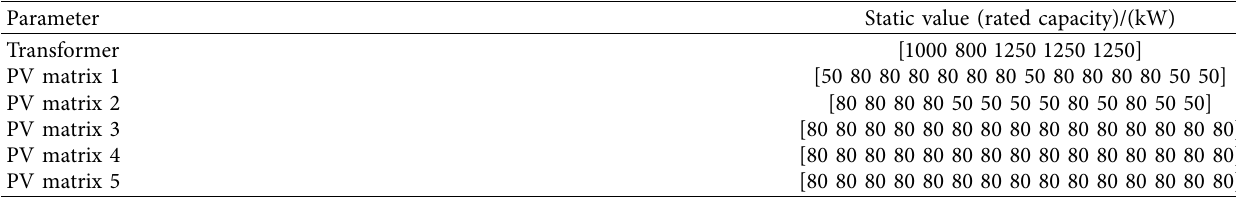
Table 3: Static parameters of PVPS